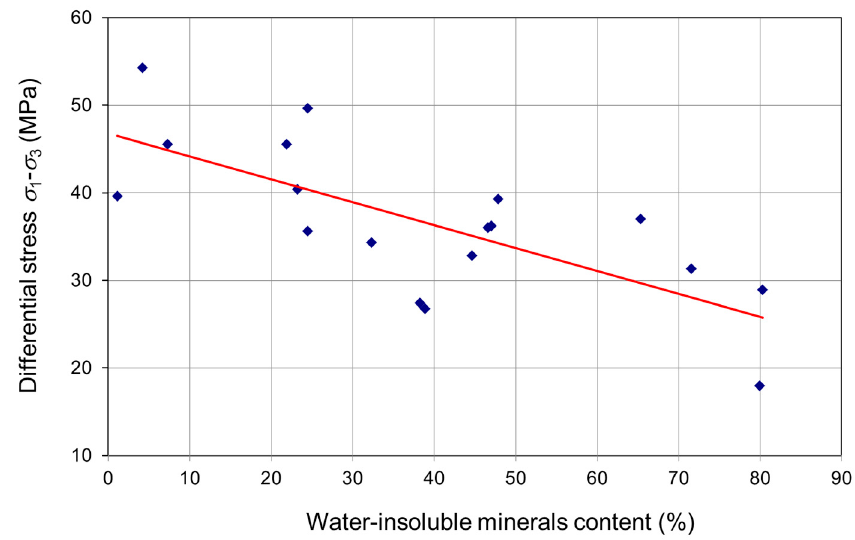
Figure 16. Dependence of the maximum differential stress value ( σ 1 – σ 3 ) on water-insoluble minerals content—tests with a constant strain rate (according to [57]).